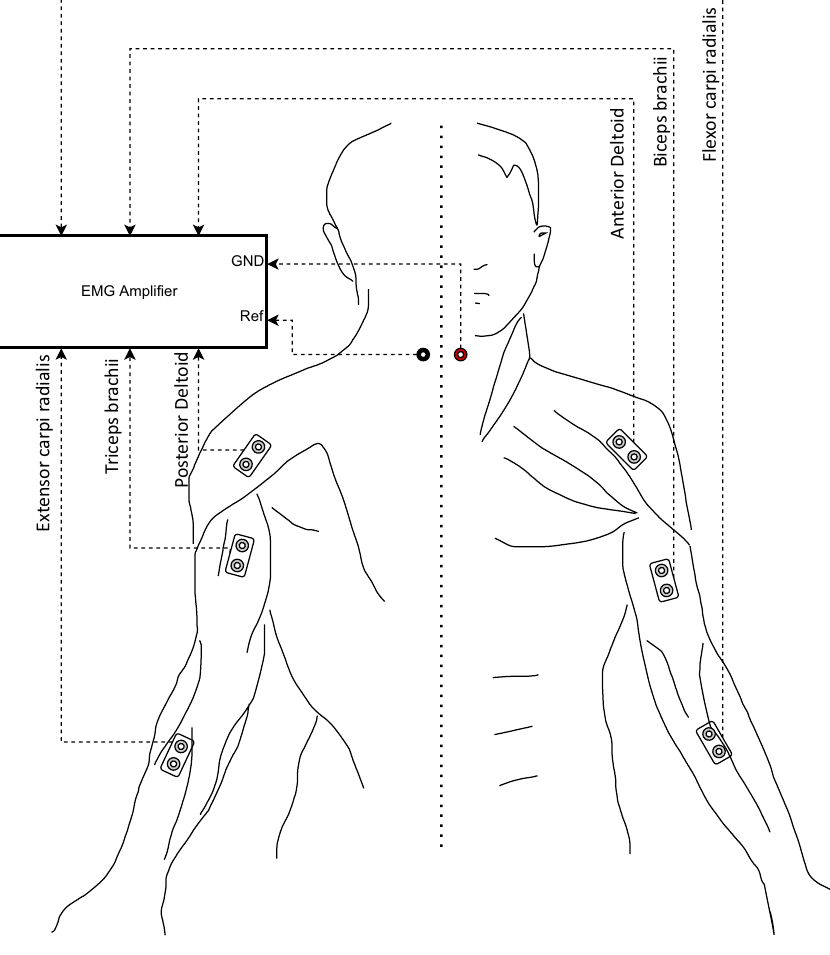
Figure 2. The configuration of the sEMG measurement system. Notice the left/right side depicts the perspective from the back/front.